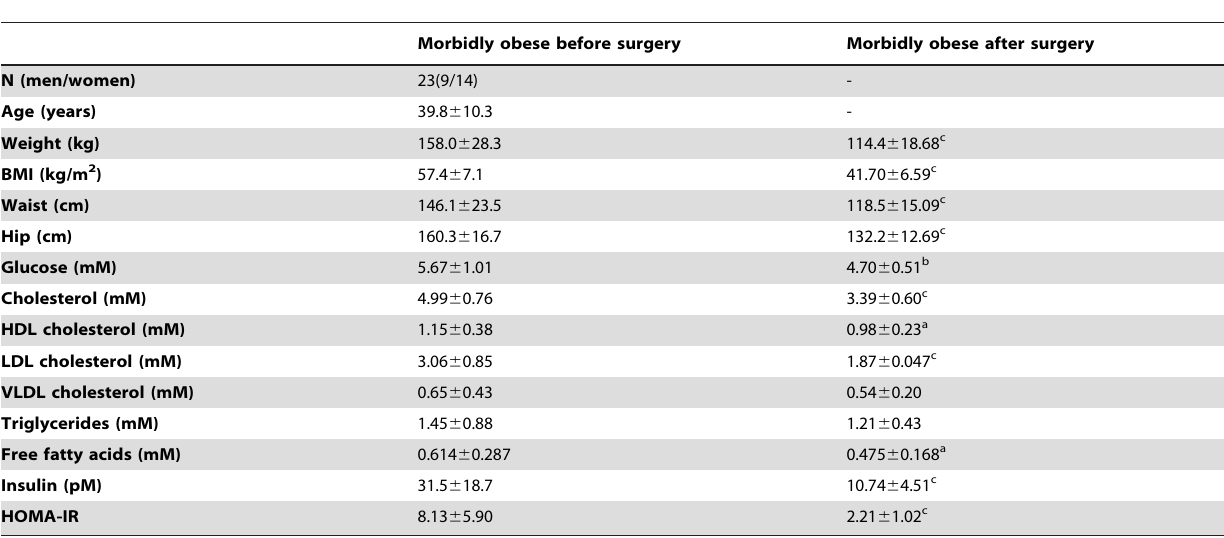
Table 1. Anthropometric and biochemical variables in the morbidly obese patients before and after surgery.